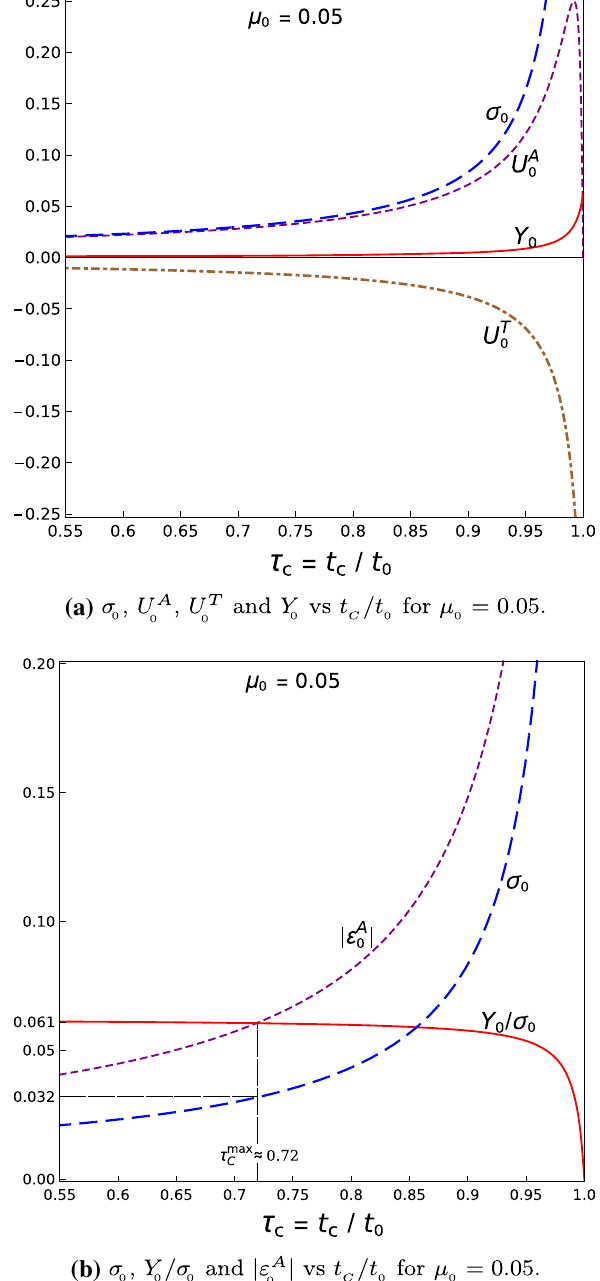
Fig. 4 Approximated variations of the parametric values of a σ and 0 the fractional changes in the torsion parameters at the present epoch, /σ viz. U A and U T , as well as their resultant Y , and b σ , Y and 0 0 0 0 0 0 | ε A | , i.e. the fractional deviation of U A from σ , with the rationalized 0 0 0 = t / t phantom crossing time τ in the viable range ( 0 . 55 , 1 ) , for a C C 0 = 0 . fixed μ 0